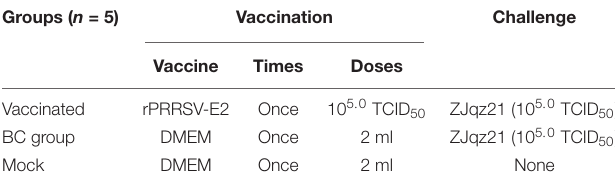
TABLE 1 | Reference strains in this study. TABLE 2 | The experimental design.